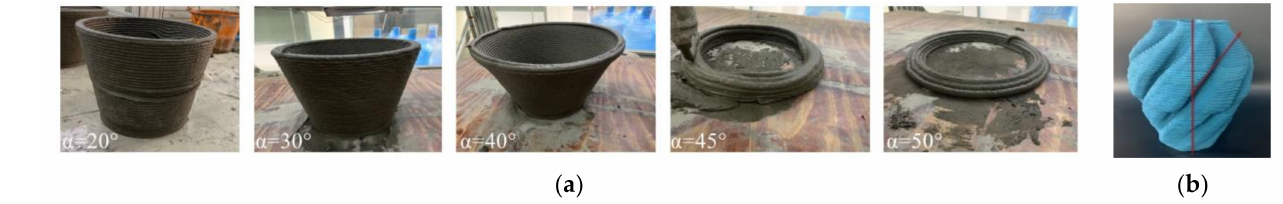
Figure 17. The leaning angle (LA) tests failed at α = 45 ◦ . ( a ) The printing tests, and ( b ) a successfully printed vase with complex geometry at maximum LA α = 36 ◦